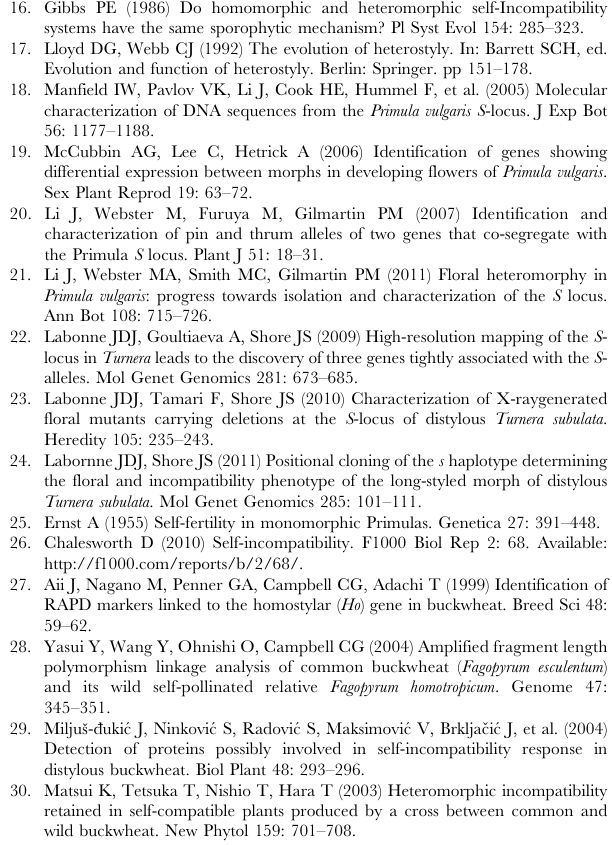
Table S2 (A) Heteromorphic and self-incompatible plants used in the study. (B) Homomorphic and self- compatible plants used in the study. Table S3 Primers used for PCR and sequence (seq) analyses. Table S4 Primers used for chromosome